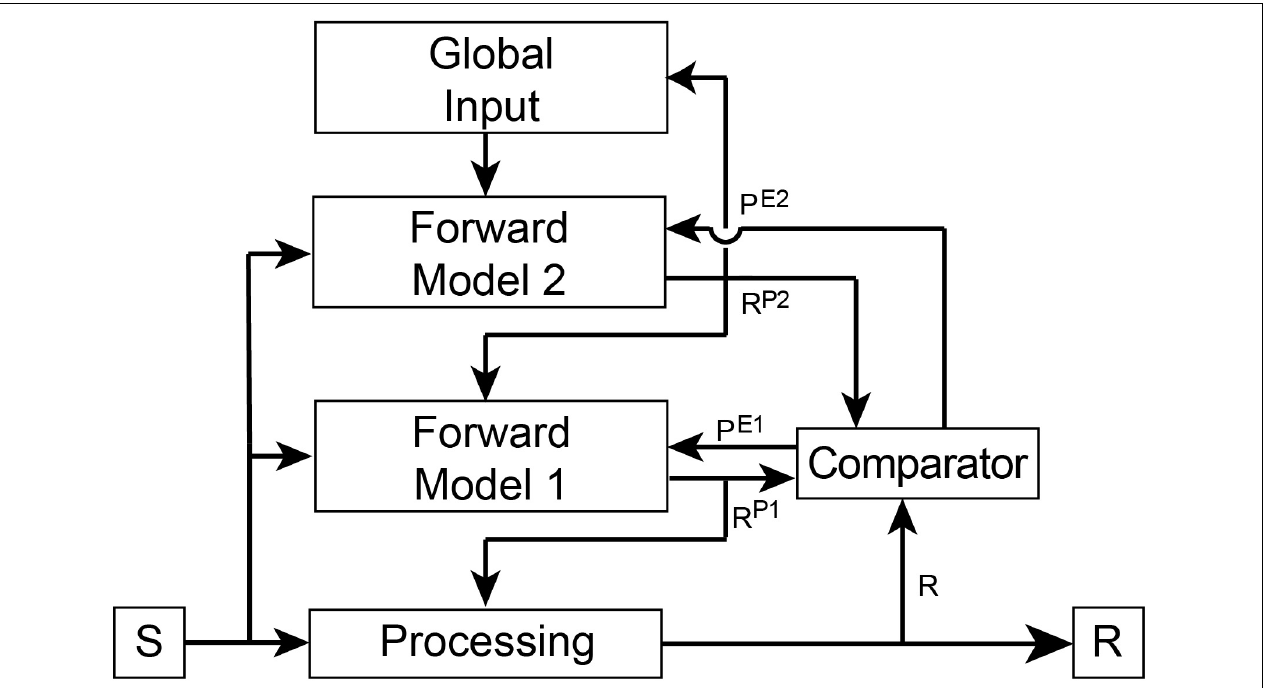
FIGURE 2 | Overview of connectivity of the hierarchical forward models algorithm. The basic architectural layout is as outlined in Figure 1 . In this Figure we include an independent Comparator region that performs a simple arithmetic operation of subtraction between its inputs to generate prediction errors (P E 1 and P E 2 ). These error signals are fed back into the appropriate Forward Model where they update internal parameters to ensure future predictions (R P 1 and R P 2 ) better match responses (R and R P 1 , respectively). The goal of the models is to minimize prediction error. Predictions are also fed back into the lower processing stream to bias ongoing processing toward the predicted response. In this way, a hierarchical top-down control process is created whereby the predictions of Forward Model 1 influence the response of the first-order processing stream and the predictions of Forward Model 2 influence the response of Forward Model 1. This hierarchical processing ensures that the response of the primary processing stream is governed by global states and both forward models. First-order and second-order awareness are therefore simultaneously contributing to control processes as well as to conscious